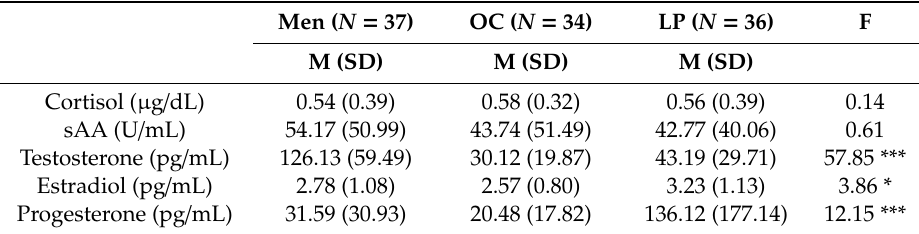
Table 1. Di ff erences between the di ff erent hormonal status groups in baseline levels of sex hormones and stress